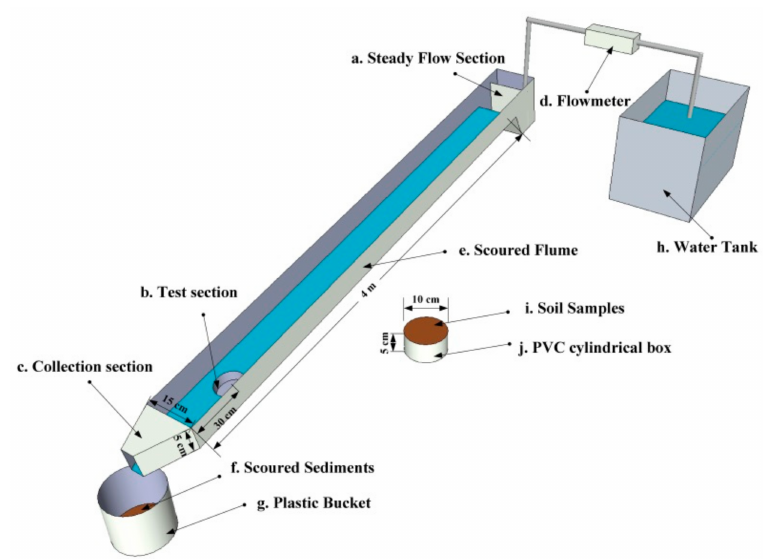
Figure 2. Schematic diagram of experimental